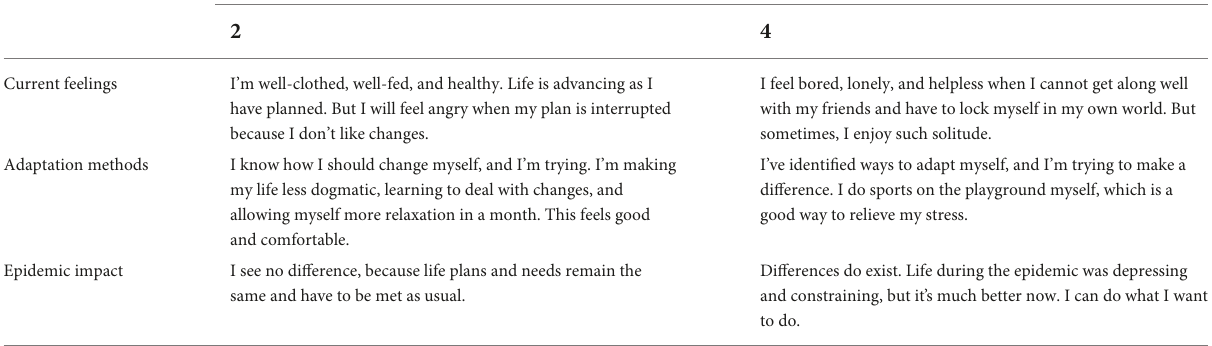
TABLE 6 Response examples about life